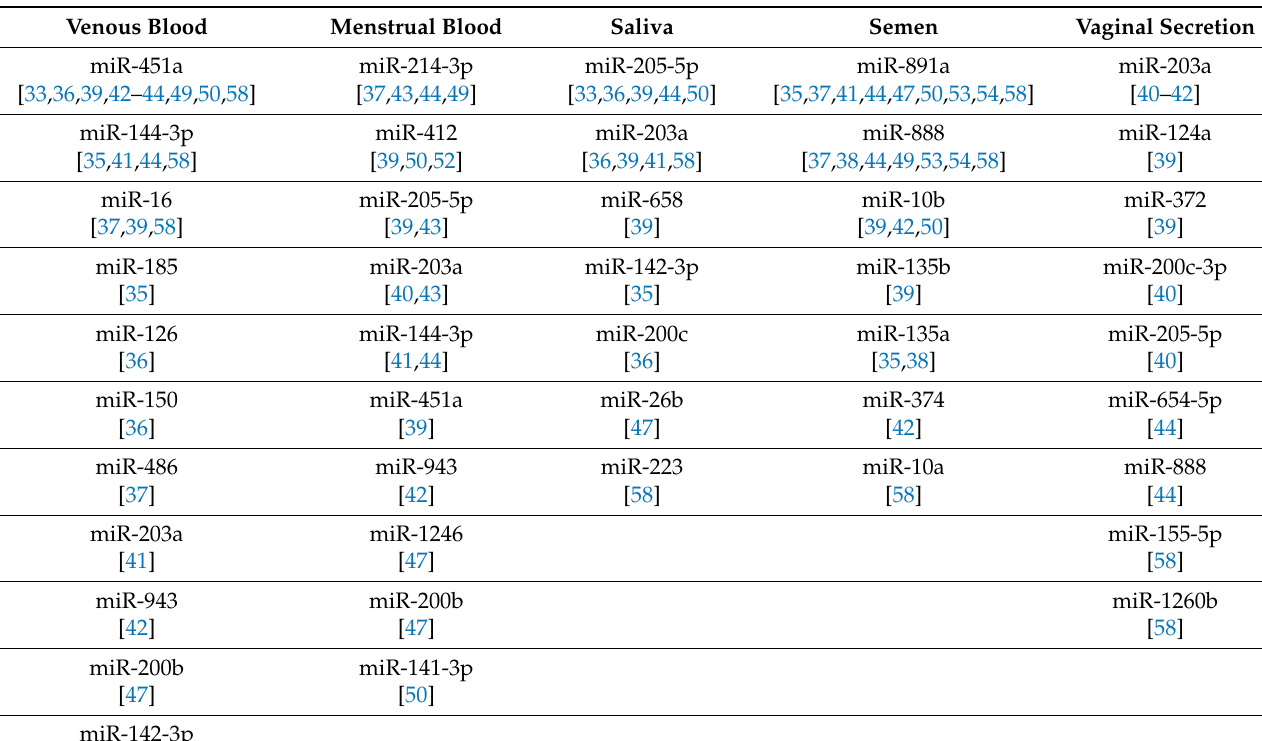
Table 1. Candidate miRNAs identified in the literature for